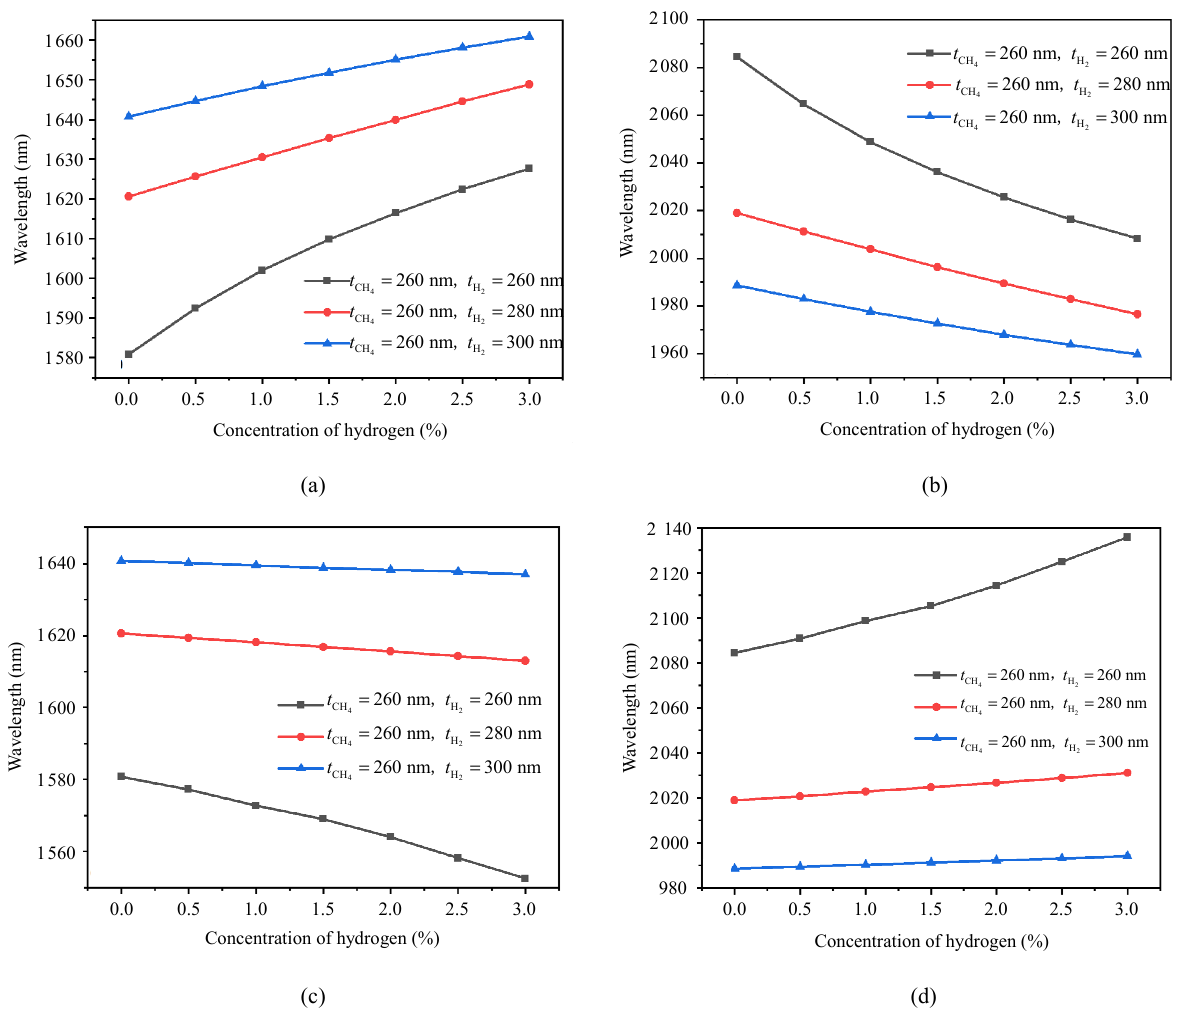
Fig. 4 Anti-Stokes peak wavelength shift curves (a) and Stokes peak wavelength shift curves (b) with the variation of the hydrogen concentration; anti-Stokes peak wavelength shift curves (c) and Stokes peak wavelength shift curves (d) with the variation of the methane